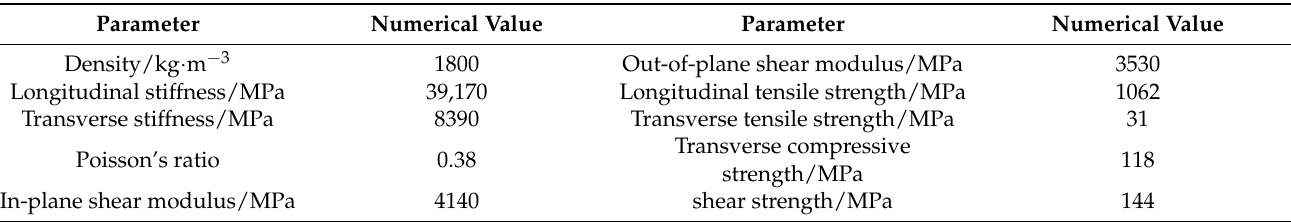
Table 2. Material parameters of E glass/epoxy for the FML [41].